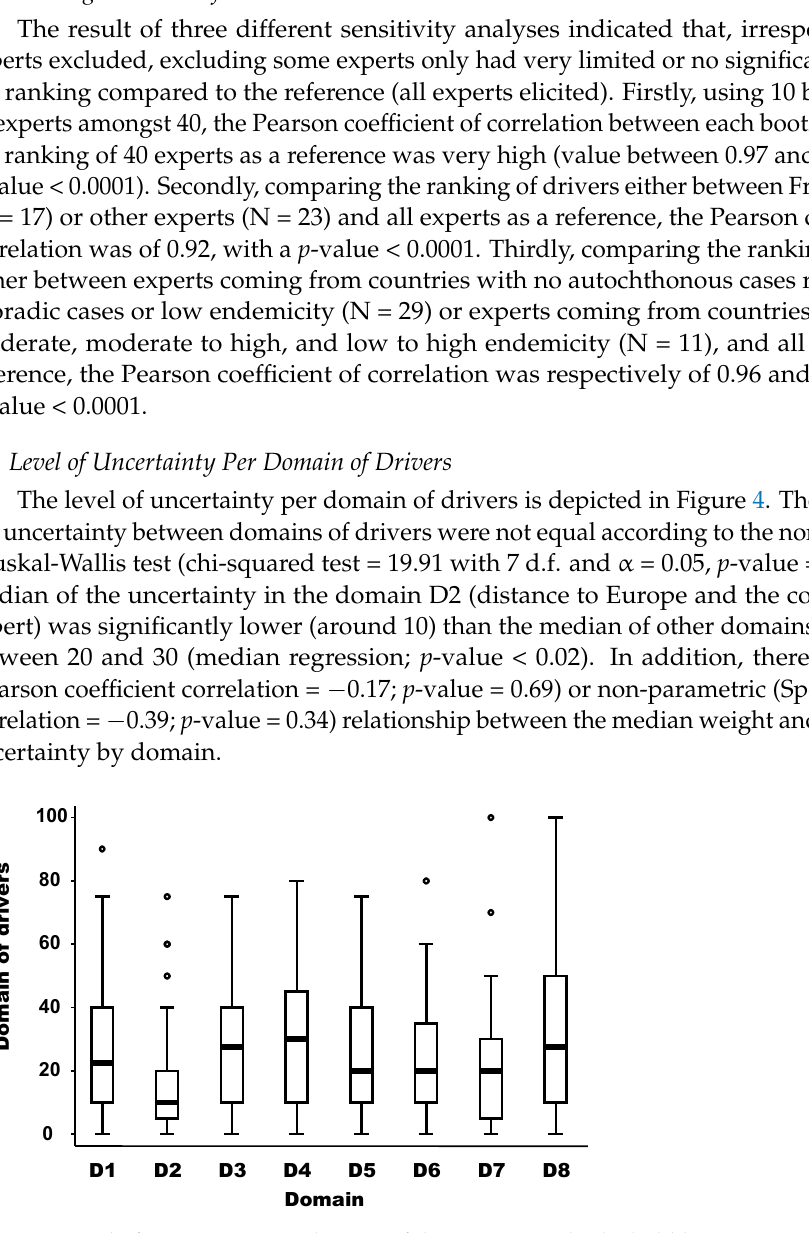
Figure 4. Level of uncertainty per domain of drivers. Legend: The bold line represents the median of the level of uncertainty attributed by experts using a scale from 0 (minimal uncertainty in the scoring) to 100 (maximum uncertainty in the scoring); the solid lines at the top and bottom of each rectangle represent, respectively, the first and third quartiles; adjacent lines to the whiskers represent the limits of the 95% confidence interval; small circles represent outside values. The eight domains of drivers are: D1, disease/pathogen characteristics; D2, distance to Europe and the country of the expert (spatial-temporal scales); D3, ability to monitor, treat, and control the disease; D4, European farm characteristics; D5, global change; D6, wildlife interface; D7, human activity; and D8, economic and trade activities.